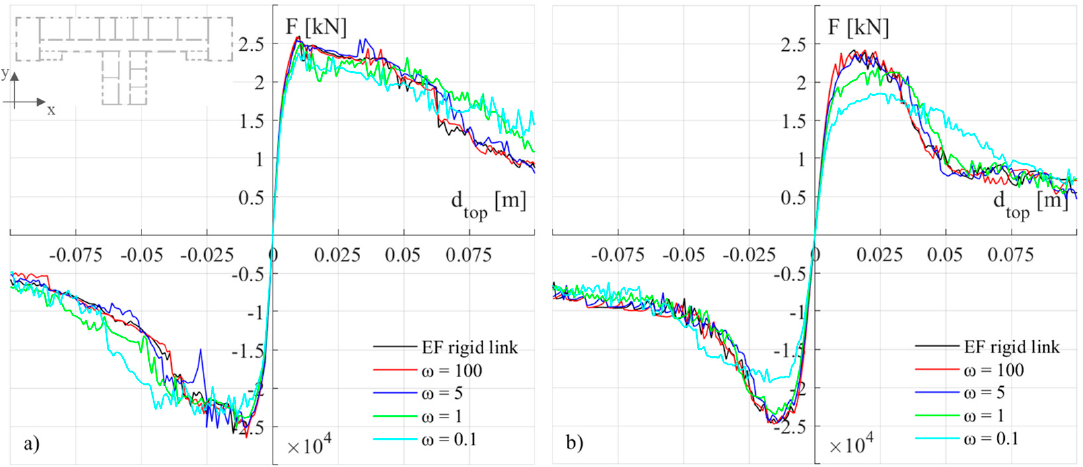
Figure 24. Sensitivity of pushover curves in X ( a ) and Y ( b ) directions varying ω values in the case of former courthouse of Fabriano.